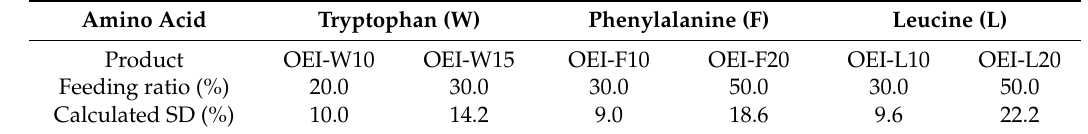
Table 1. The products obtained by the modification of OEI and their SD calculated from 1 H NMR spectra.